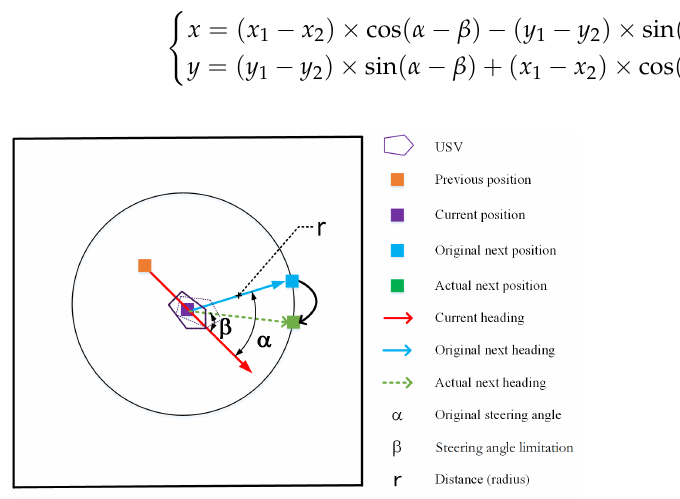
Figure 3. Next position calculation with steering angle limitation.